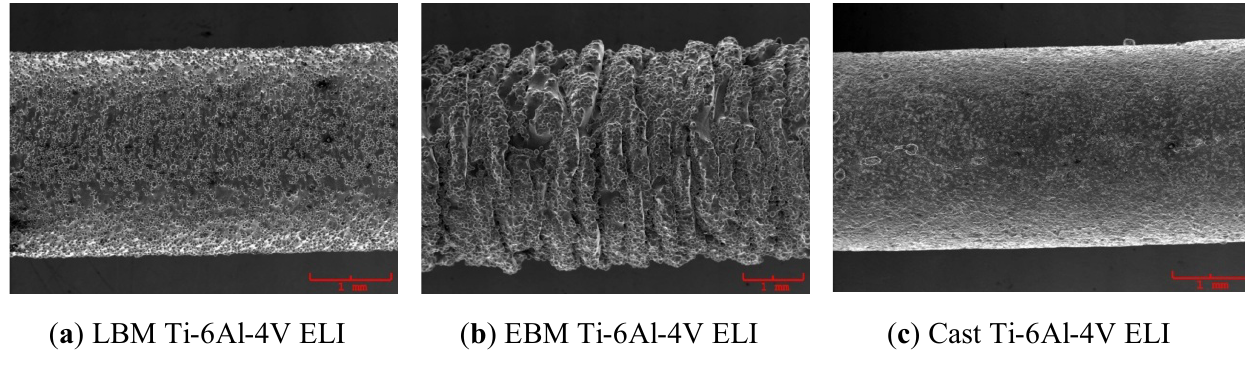
Figure 4. Enlarged views of ( a ) an LBM specimen; ( b ) an EBM specimen; ( c ) a cast Ti-6Al-4V.